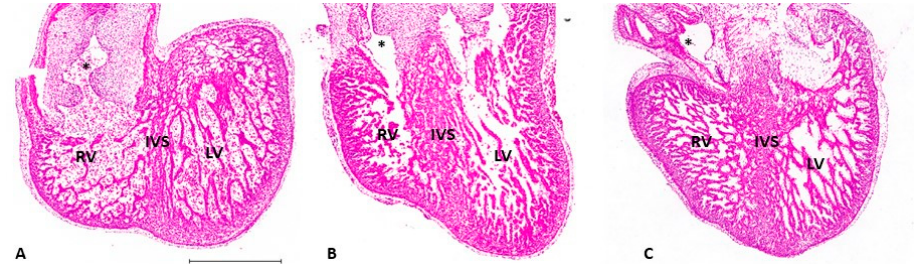
Figure 9. Histological images of the developing ventricles at HH29 demonstrate different ventricular morphology following OTB. Sectioned chicken embryonic hearts at HH29 were stained with Hematoxylin (nuclear marker) and Eosin (cytoplasmic maker) and imaged at 20× magnification. The figure compares the ventricles of ( A ) a control heart, ( B ) an OTB heart with a band tightness of 42%, and ( C ) an OTB with a band tightness of 47%. Hearts subjected to OTB ( B , C ) exhibit denser trabeculae and increased compact myocardium thickness. The heart subjected to 42% band tightness ( B ) demonstrates a narrowing of the ventricle towards the apex of the heart, while the heart subjected to 47% band tightness ( C ) demonstrates a more spherical shape. LV: left ventricle; RV: right ventricle; IVS: interventricular septum; *: start of OFT. Scale bar = 500 µ m. Embryos that experience a decrease in hemodynamic load, such as those